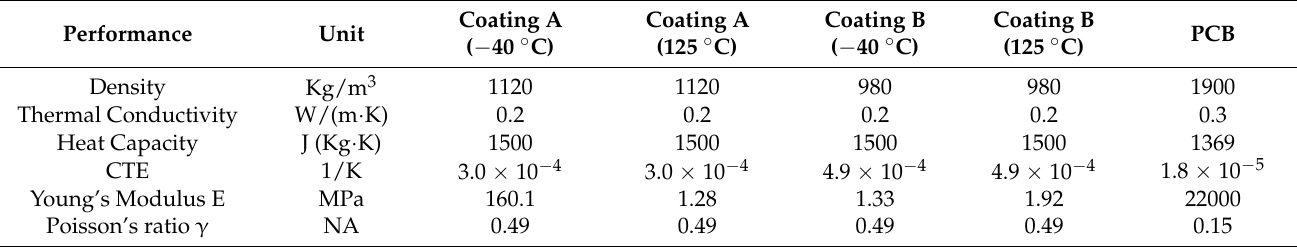
Table 2. Material properties input used for both the simplified model and the 2D FEA